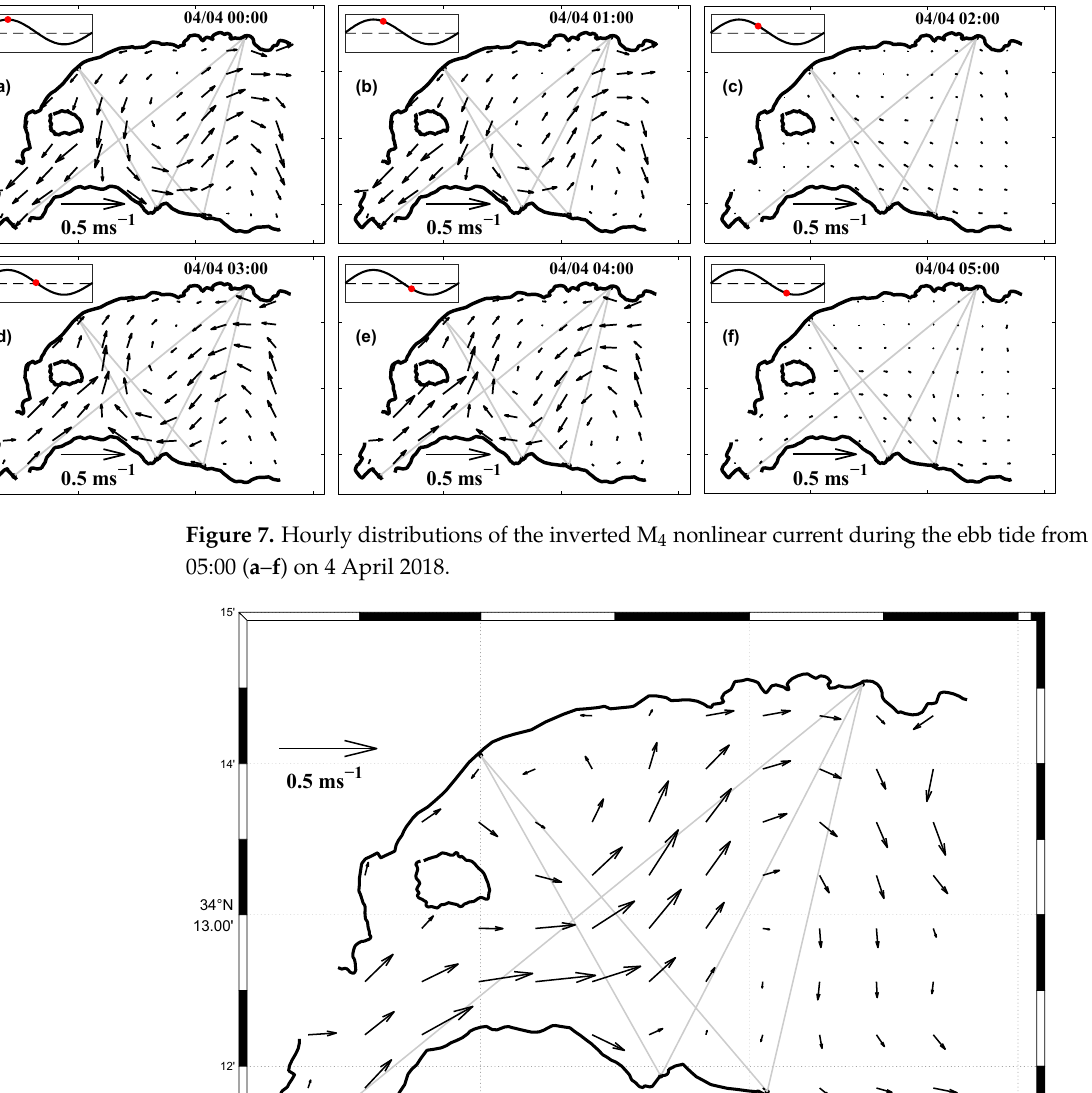
8 of 13 Figure 6. Hourly distributions of the inverted M 2 tidal current from 00:00 to 11:00 ( a – l ) on 4 April 2018. The corresponding sea level heights were plotted with a red dot in the sub-figures at the up- per-left corner. Figure 7 shows the horizontal distributions of the M 4 nonlinear current field at hourly intervals during one cycle of M 4 current from 00:00 to 05:00 on 4 April 2018. The central area of the model domain was occupied with a meandering pattern of counterclockwise rotation in the first two hours (00:00 and 01:00) of the M 4 current (Figure 7a,b). However, at 02:00, no such current was observed (Figure 7c), and its phase corresponded to the first